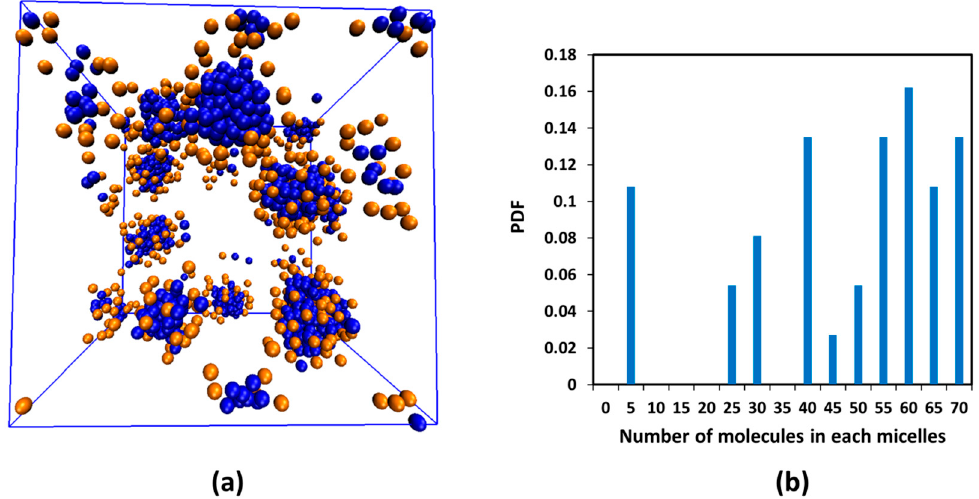
Figure 10. ( a ) The equilibrium snapshot of 2 wt % SDS in water. All of the water beads are removed for clarity. Blue and orange beads represent the tail and head beads of the surfactant, respectively; ( b ) the distribution of number of molecules in each SDS micelle in water.